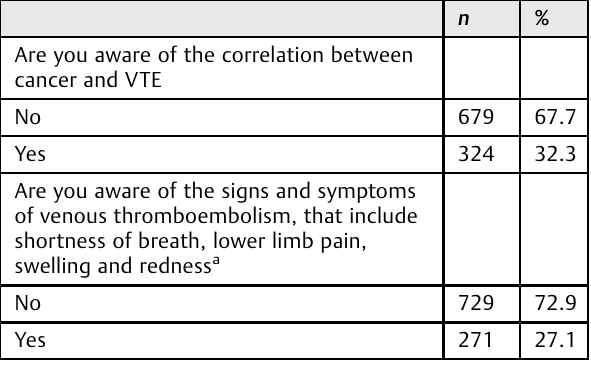
Table 2 Awareness of VTE ( n ¼